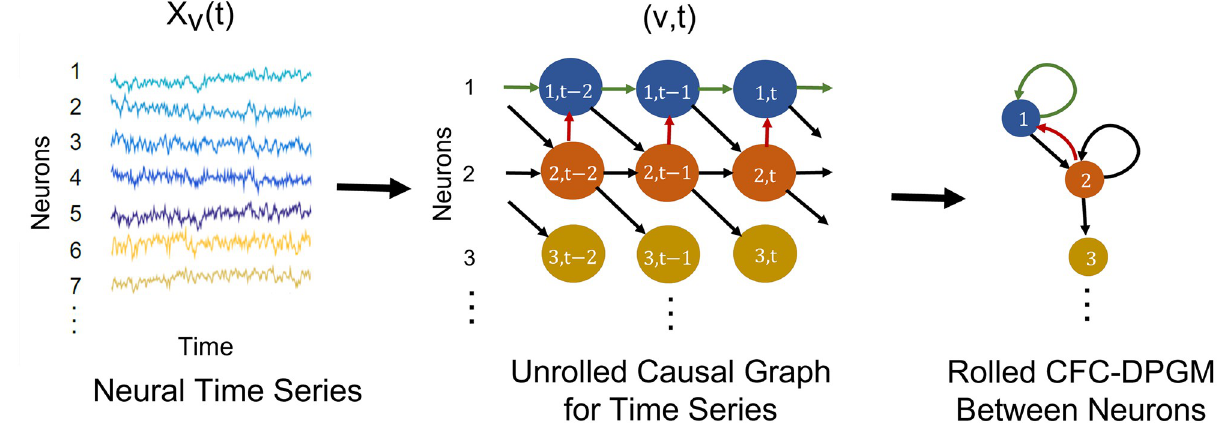
Fig 1. Causal modeling of neural time series. Schematic depiction of causal modeling of the neural time series (left) by the Unrolled Causal Graph (middle), and then rolling back its edges (colored) to define the Rolled CFC-DPGM